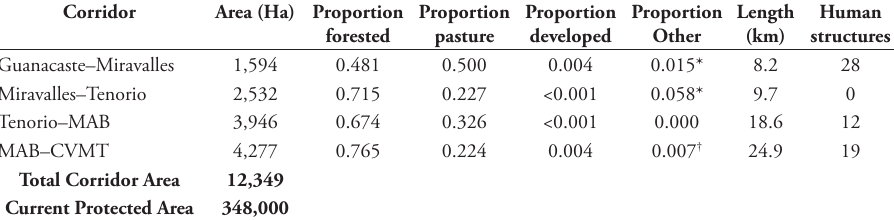
Table 1. Current physical characteristics of proposed biological sub-corridors in northwest Costa Rica that would produce a contiguous protected area from the Guanacaste Region (Santa Rosa NP) to the Cen- tral Volcanic Mountain Range. *indicates area covered in recent volcanic activity with sparse, but natural vegetation. † indicates barren land caused by ongoing road construction.